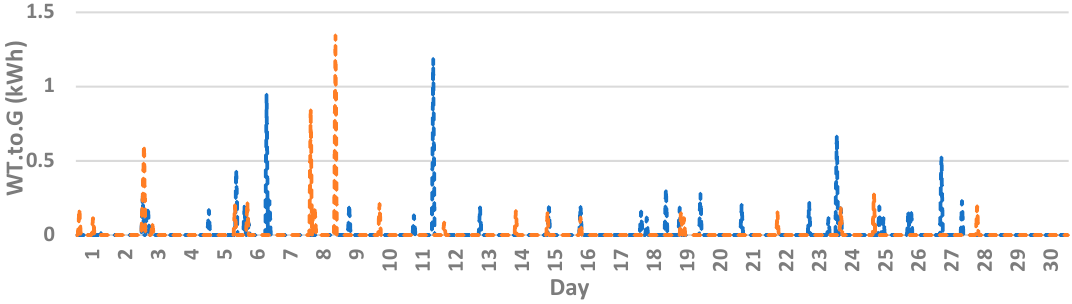
Figure 12. Energy transmission from wind turbines to loads, for a single dwelling. Comparison between the most and least probable scenarios (blue and orange) for one month (April). Source: self-elaboration.